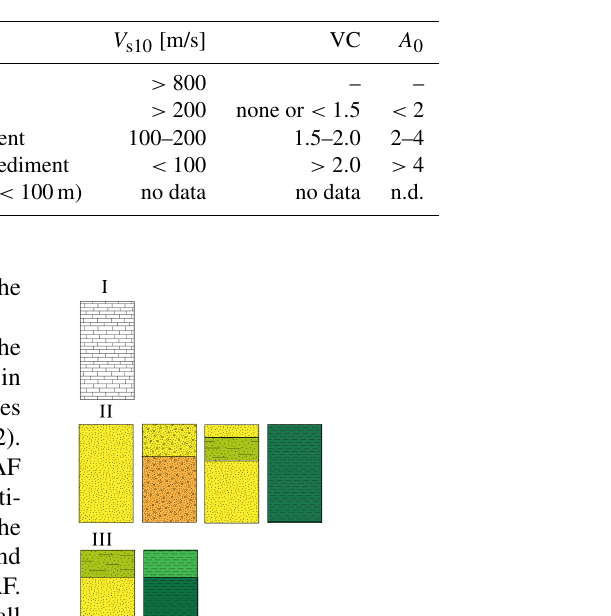
Table 1. Details of the NL classification. The V s10 and velocity contrast (VC) values assigned to each class are based on the amplification relationships presented in Sect. 4 and Appendix A. For class V there are no empirical data available relating V s10 and VC with A 0 (HVSR peak amplitude), hence not determined (n.d).